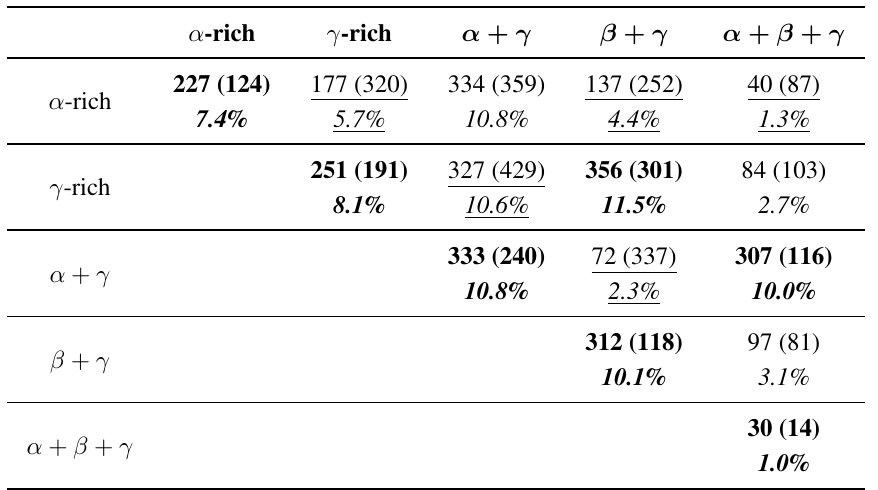
Table 4. Numbers and percentages of observed DFIs for all pairs of DFBS SSE classes in our dataset of 3084 DFIs. In parentheses is the number of DFIs expected if the binding occurs randomly between any two SSE classes of DFBSs. Statistical testing identifies percentages that are significantly higher (bold) or lower (underlined) than the percentages expected from random